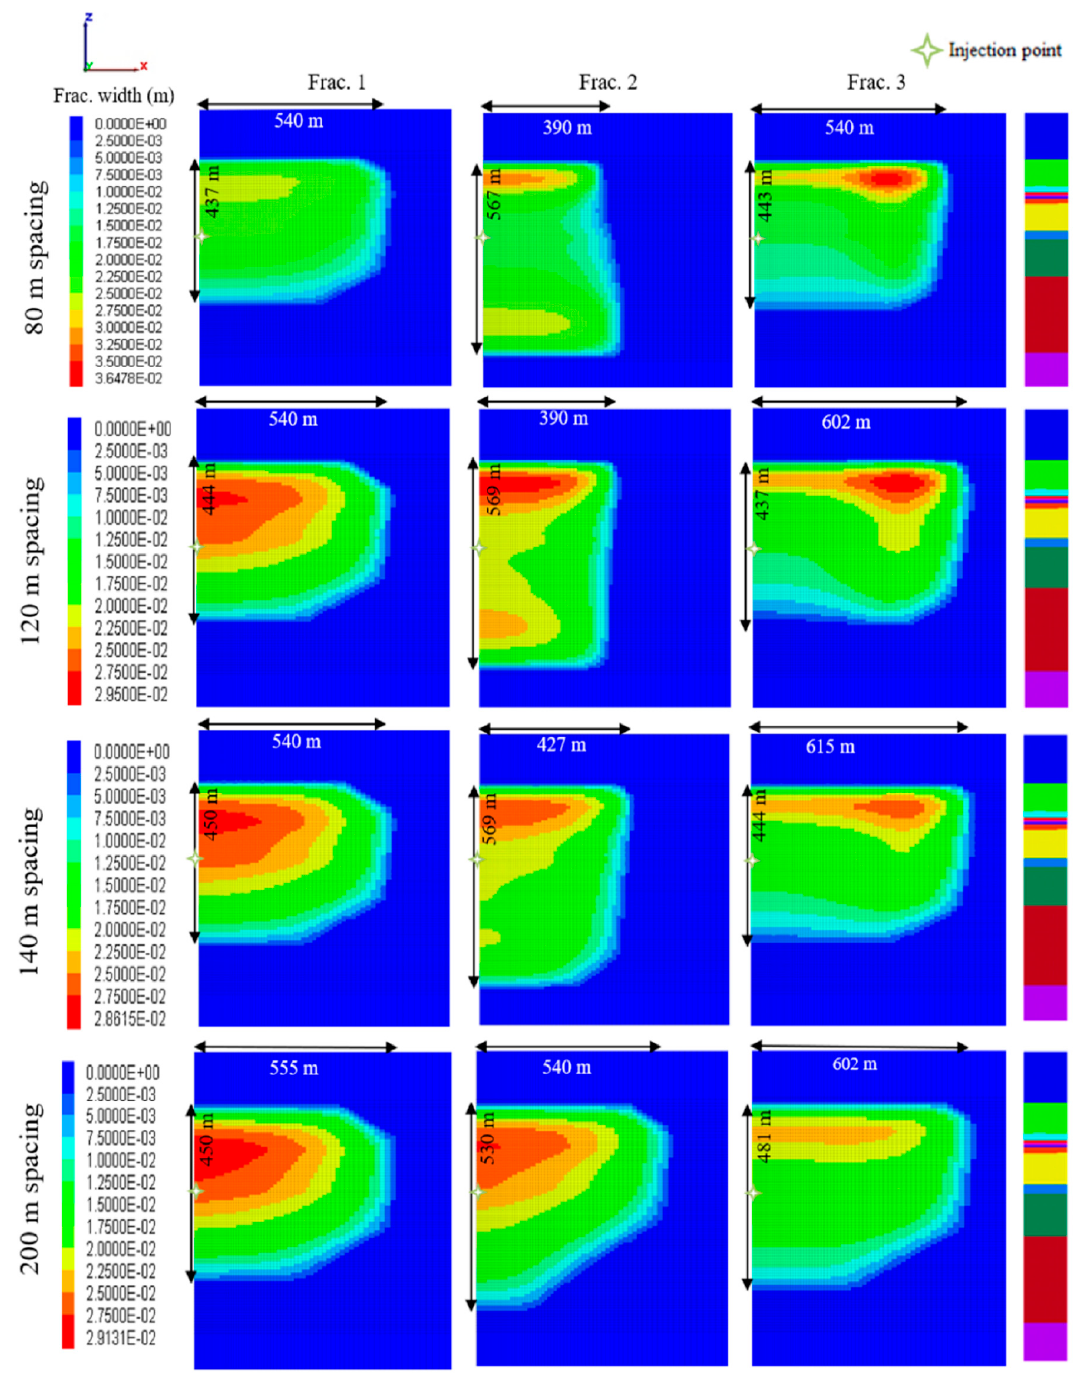
Figure 19. Comparative configurations of three fractures with corresponding widths over 80, 120, 140, and 200 m fracture spacing.